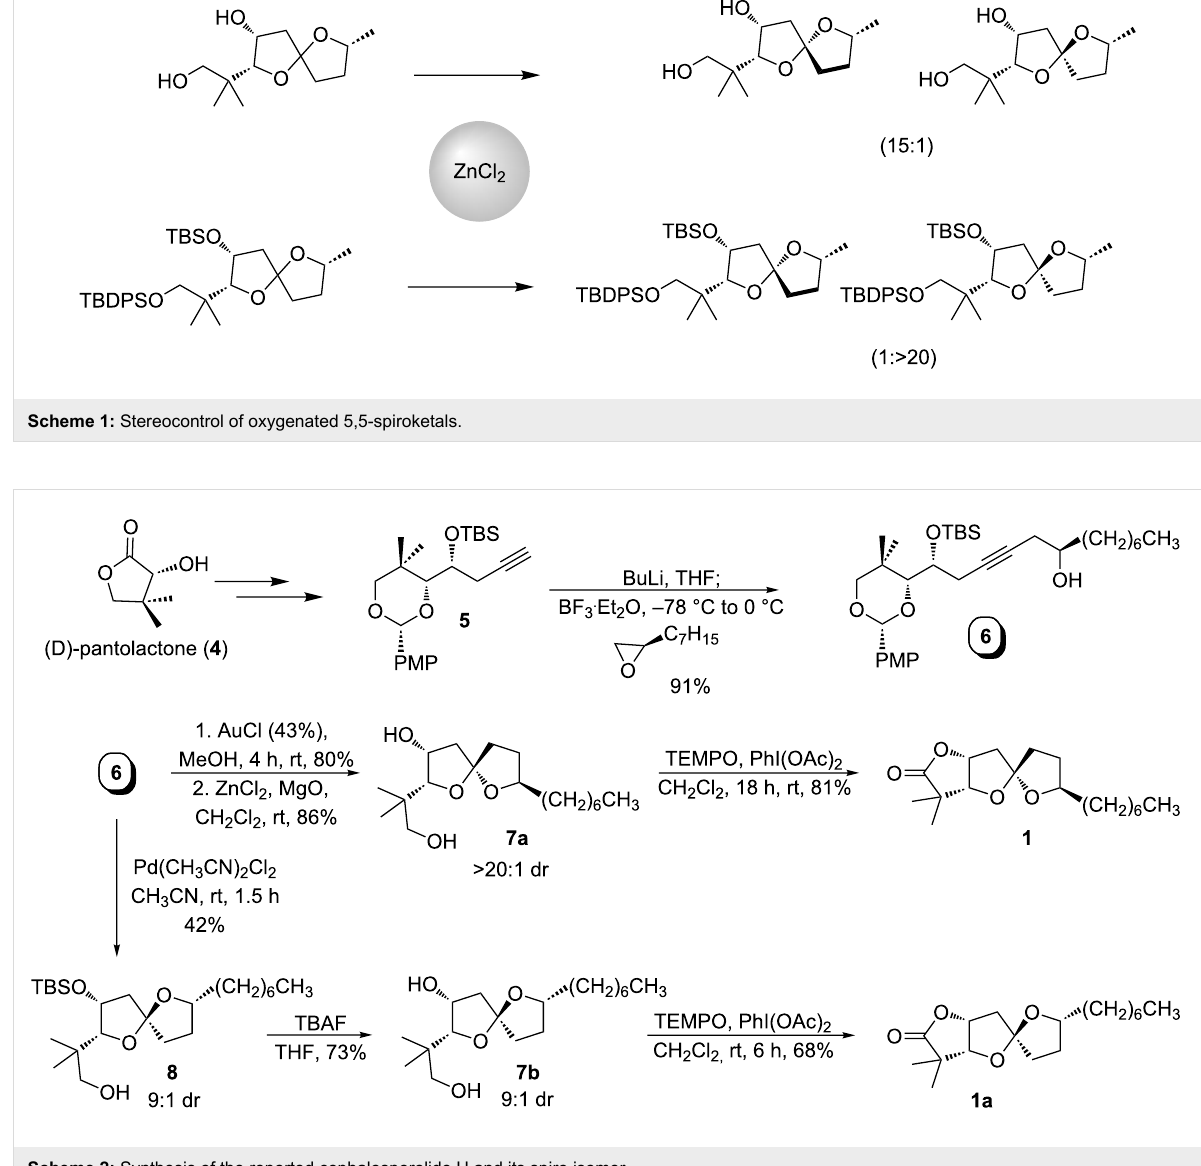
Scheme 2: Synthesis of the reported cephalosporolide H and its spiro